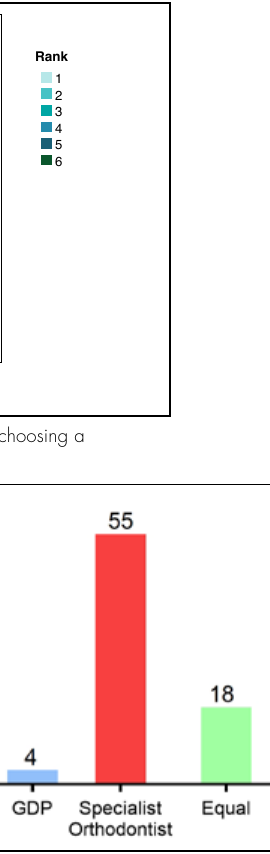
Figure 9. Frequency histogram for response to Question 4: ‘In your opinion, who is more qualified to perform orthodontic treatment?’.